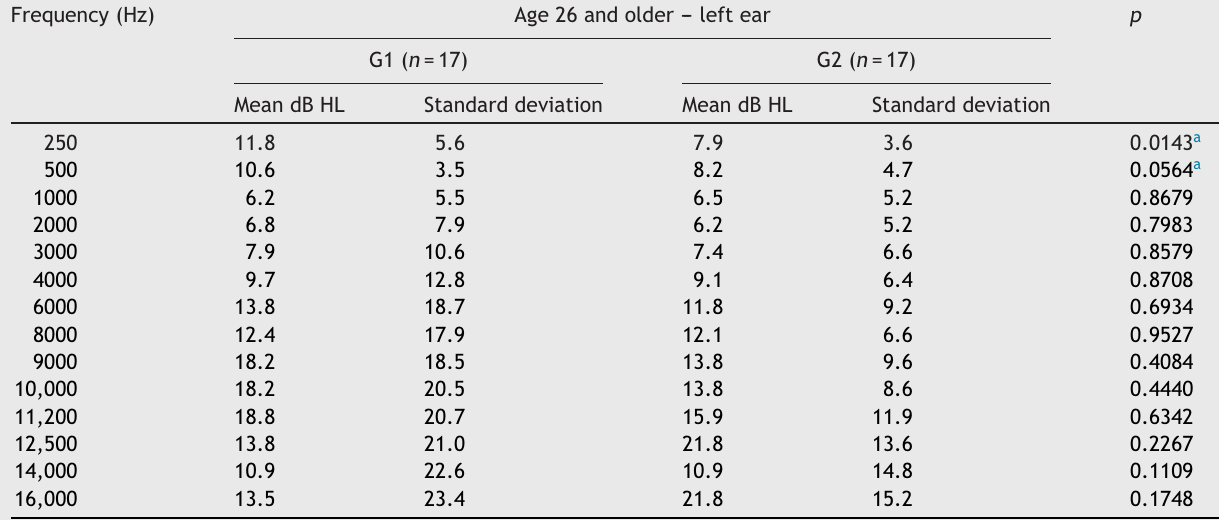
Table 7 Mean pure-tone air-conduction thresholds in the left ear, by frequency, for age range 26 and older, in groups G1 and G2 ( n =